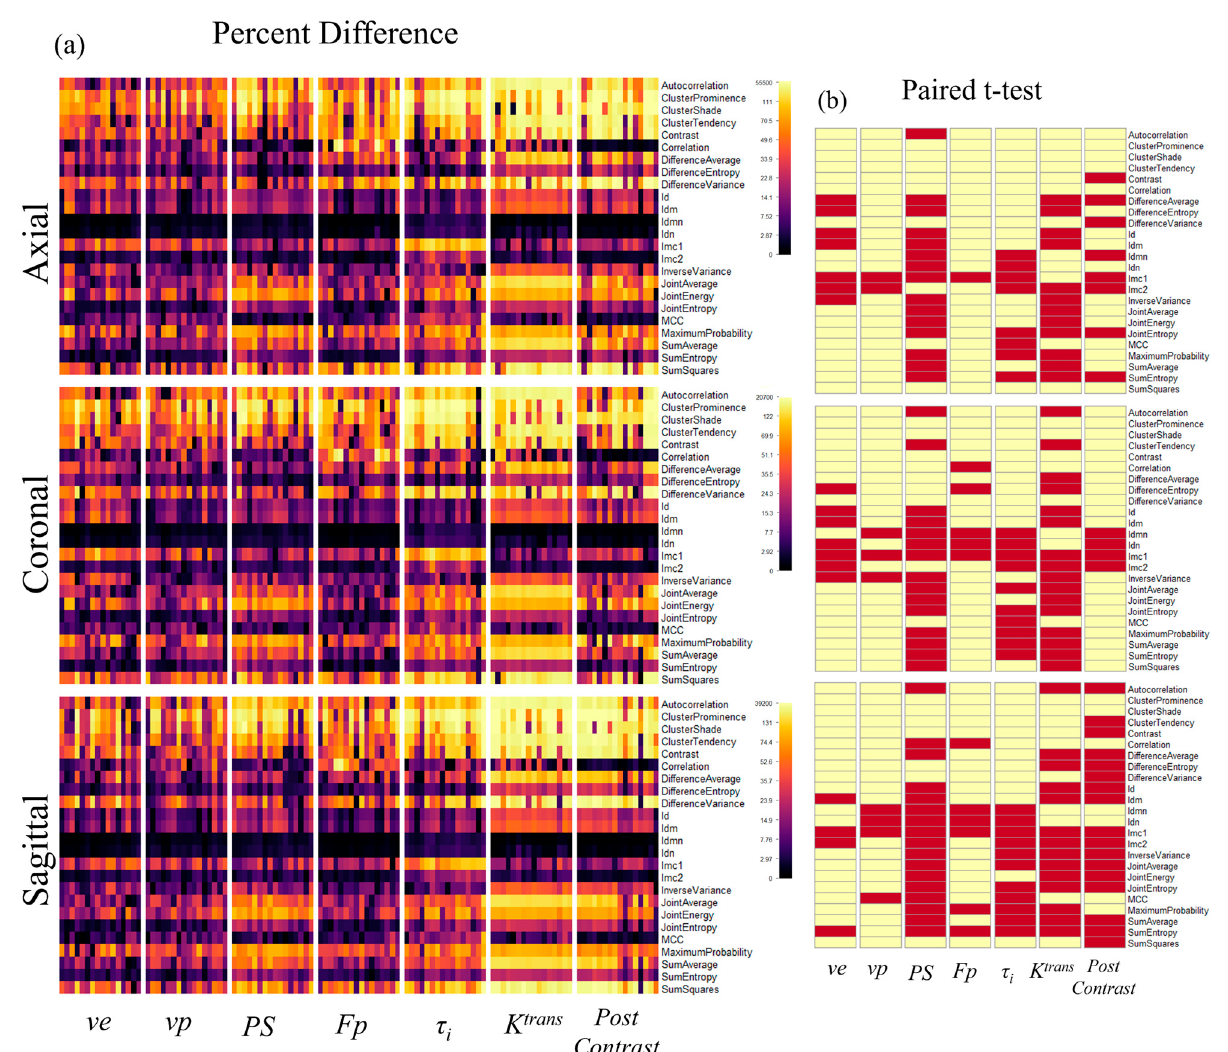
Figure 6. The percent difference and significance between Grey Level Cooccurrence Matrix (GLCM) texture features from isotropic and anisotropic images of different orthogonal orientations. ( a ) A heatmap depicting the percent difference in texture features calculated from GLCM between isotropic parameter maps and anisotropic maps of different orthogonal orientations. Anisotropic maps were simulated from the isotropic images in three orthogonal directions, all demonstrating similar patterns in the difference. ( b ) A heatmap showing the features that have a significant difference in radiomic features ( p < 0.00054, depicted in red) between isotropic and anisotropic image resolution, which are between 32% and 34% of total features.